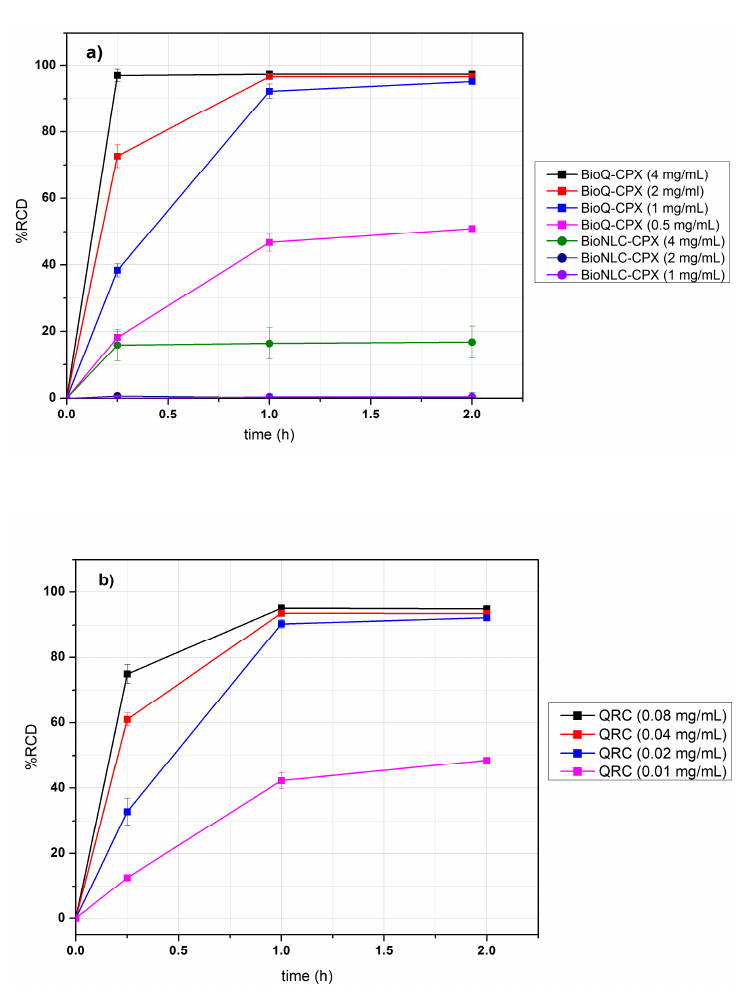
Figure 11. Percentage of residual concentration of DPPH (%RCD) radical form as a function of incubation time, analyzing: ( a ) BioQ-CPX at 4, 2, 1 and 0.5 mg/mL (squares) and BioNLC-CPX at 4, 2 and 1 mg/mL (circles) samples; ( b ) pure QRC at 0.08, 0.04, 0.02, and 0.01 mg/mL; means ± SE ( n = 3). The QRC (pure drug) antioxidant activity (Figure 11b), evaluated at concentrations corresponding to QRC content in the nanocomposite samples, showed the same values of %RCD and trends after 1 and 2 h, while the scavenging activity was lower within 15 min